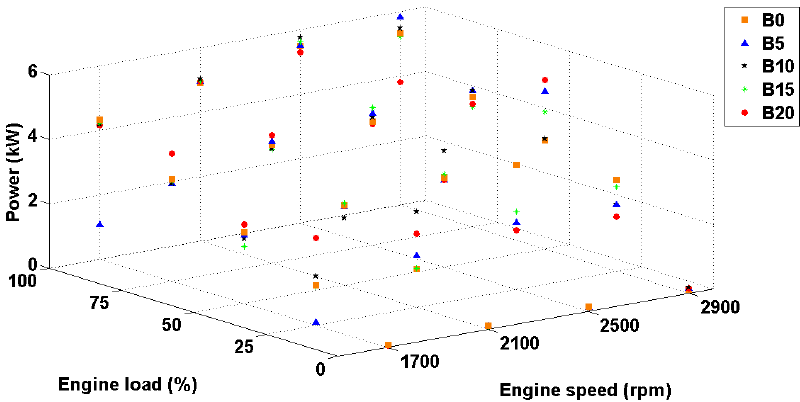
Figure 4. Power of the engine for different engine loads, speeds and biodiesel percentages.